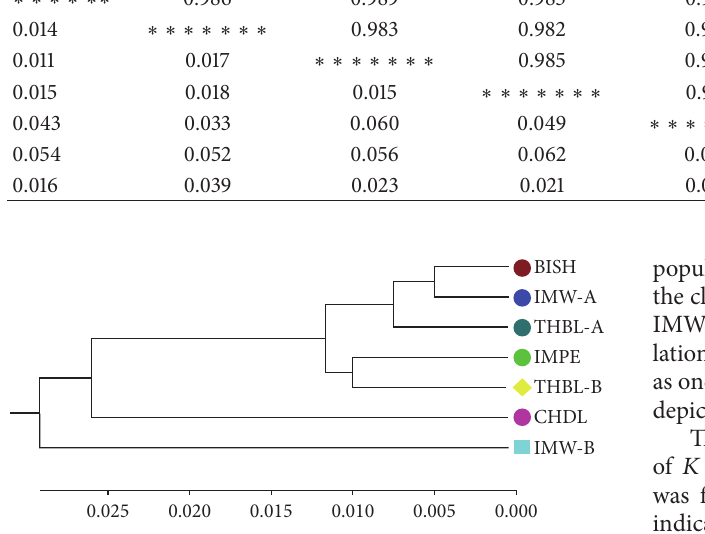
Figure 4: UPGMA dendrogram based on Nei’s (1972) unbiased measures of genetic distance among 7 populations of M.